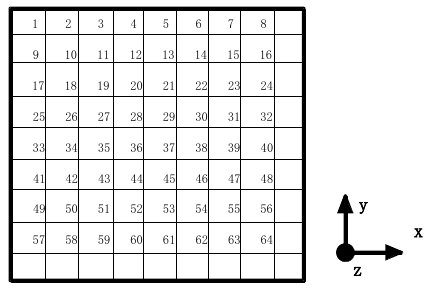
Figure 1. The grid division of composite.